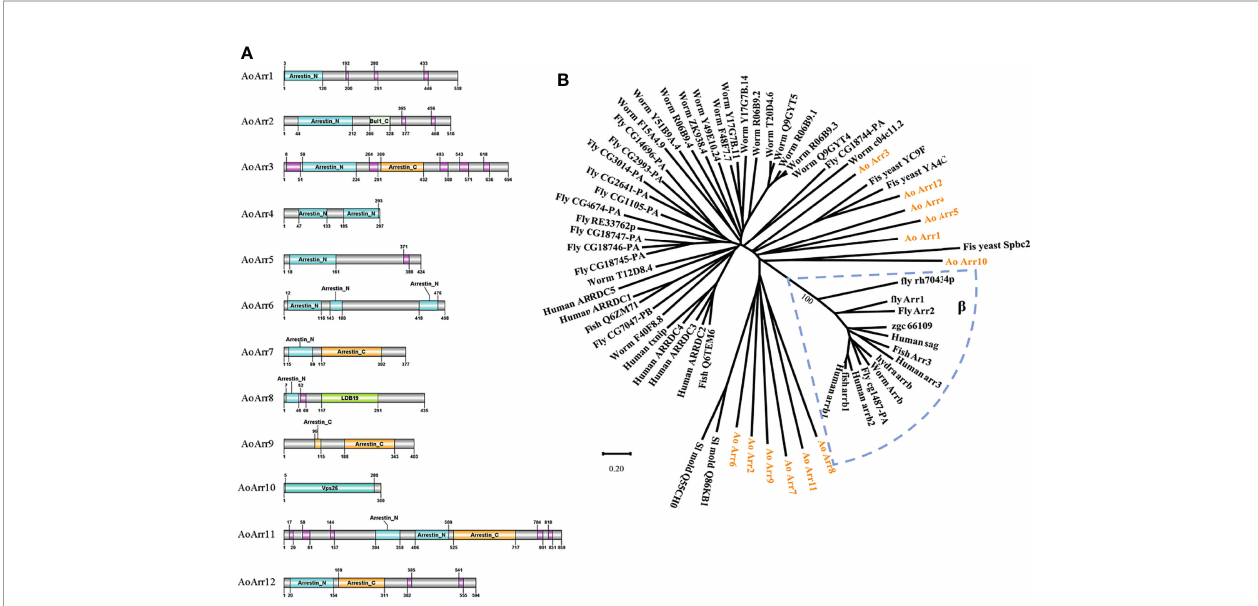
FIGURE 1 | Bioinformatics analysis of arrestin-related proteins. (A) Prediction of the domain of arrestin-related proteins in Arthrobotrys oligospora . The number represents the number of amino acids in each protein, and the pink module represents low complexity. Among them, Bul1_C, LDB19, and Vps26 domains belong to the arrestin family. (B) The phylogenetic tree analysis of arrestin of related species. The 12 arrestin proteins of A. oligospora studied in this paper are represented by orange characters, the blue dashed box represents the b -arrestin family, and the remaining black lines represent the a -type arrestin family. The evolutionary tree is drawn using the MEGA6